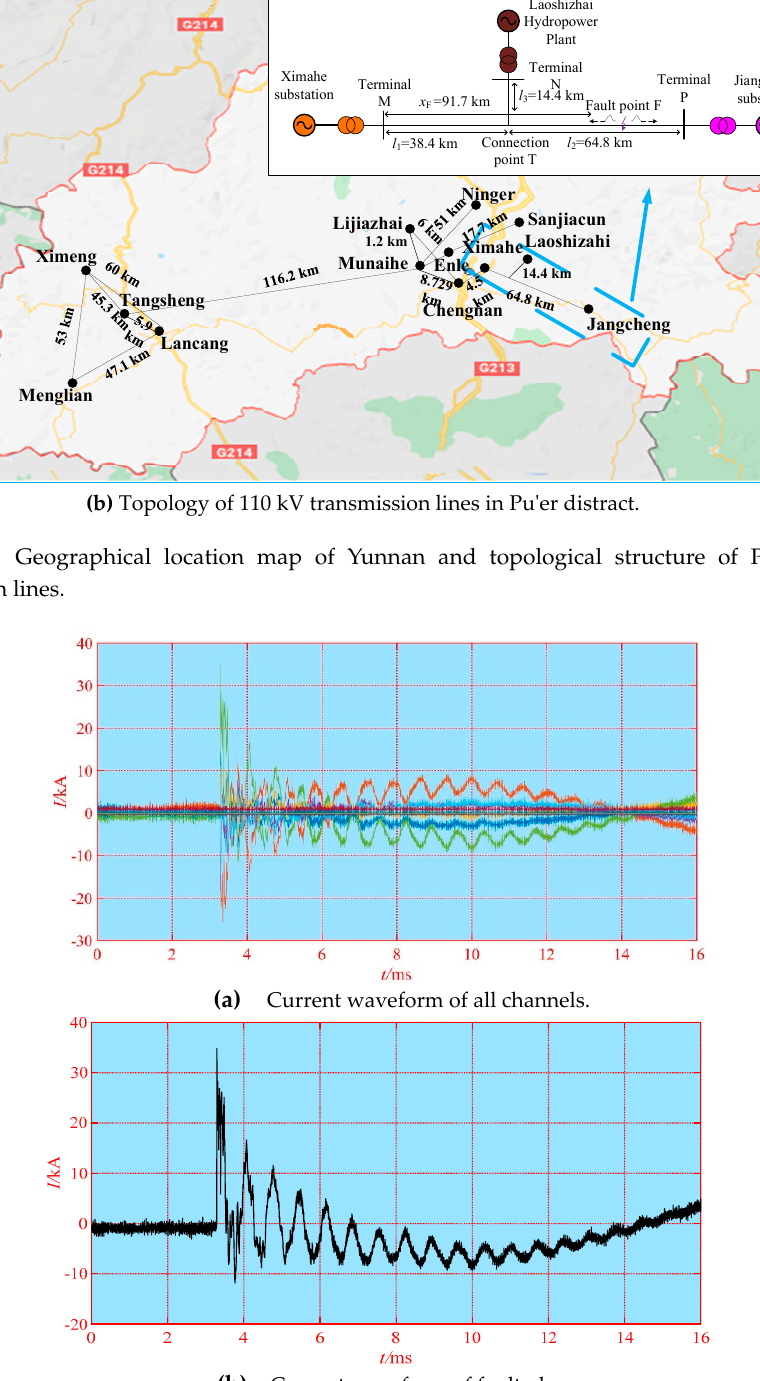
Figure 17. Waveform diagram of measured data.